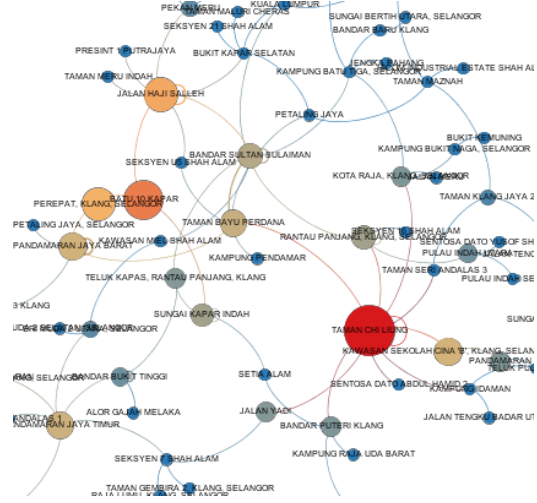
Figure 13. Betweenness Centrality Network Graph.